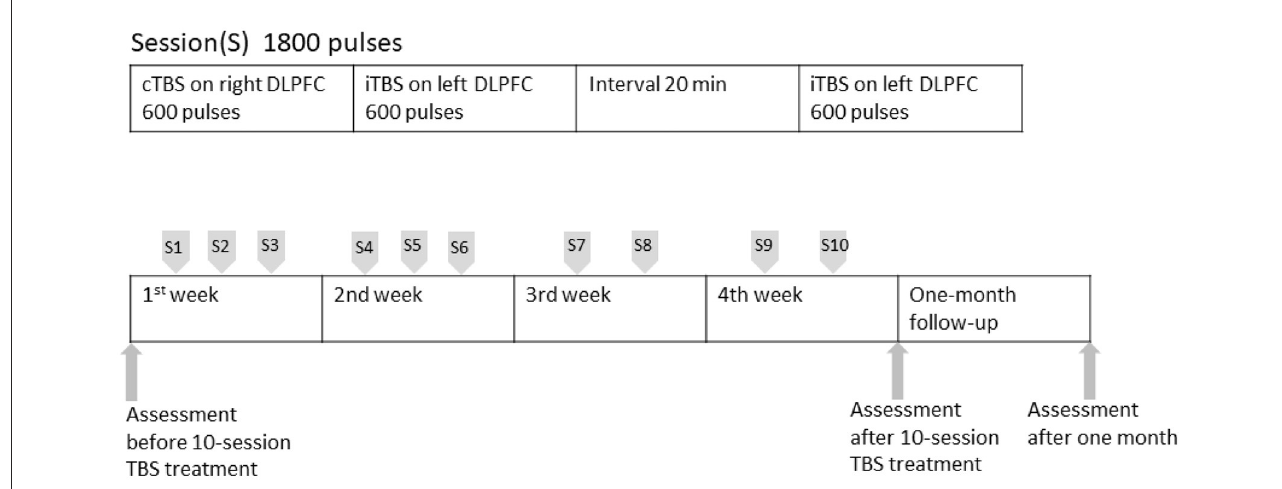
FIGURE1 TBS procedure